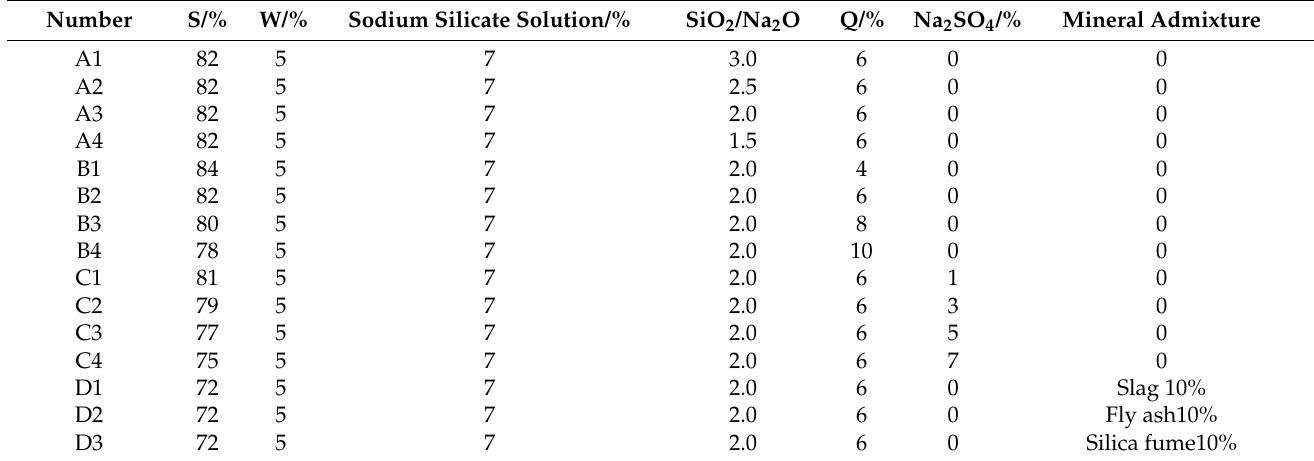
Table 5. Mixture proportion of